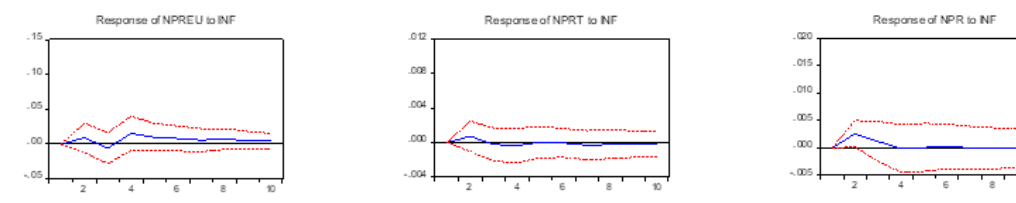
Figure 4C. During the COVID-19 outbreak (outside Java